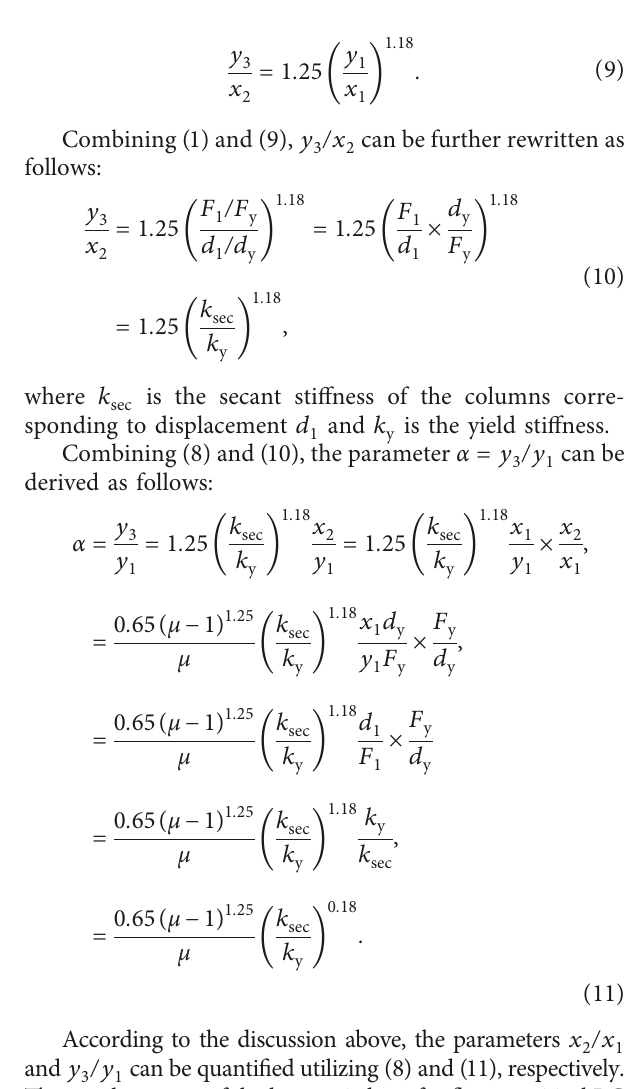
/x /x and y 3 2 1 1